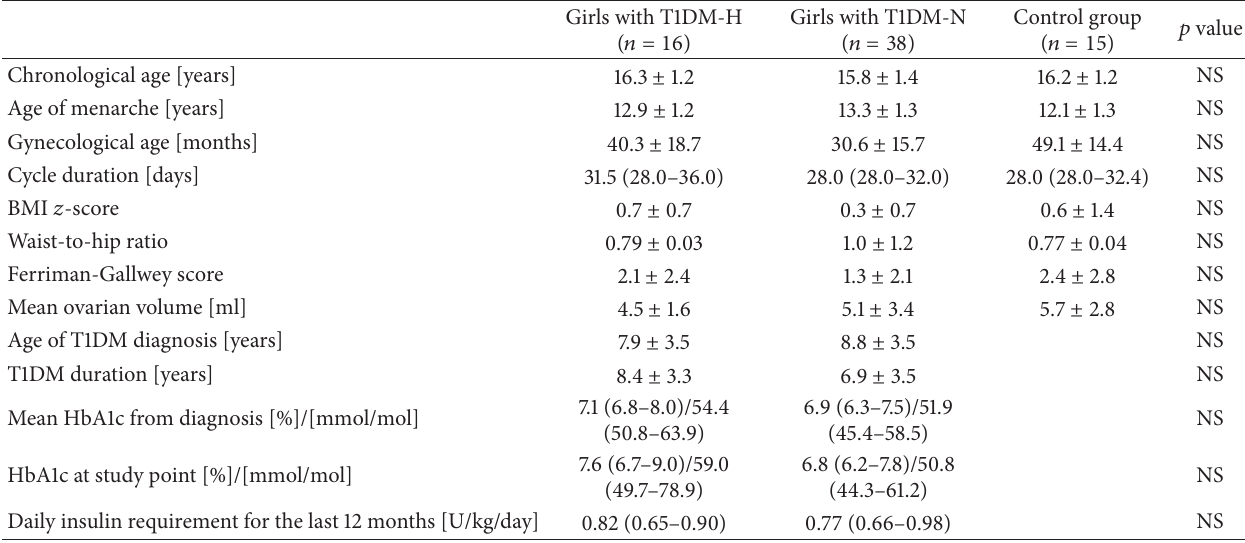
Table 1: Clinical characteristics of adolescent girls with type 1 diabetes mellitus with (T1DM-H) and without hyperandrogenemia (T1DM-N) and healthy, regularly menstruating girls with normal androgen level (control